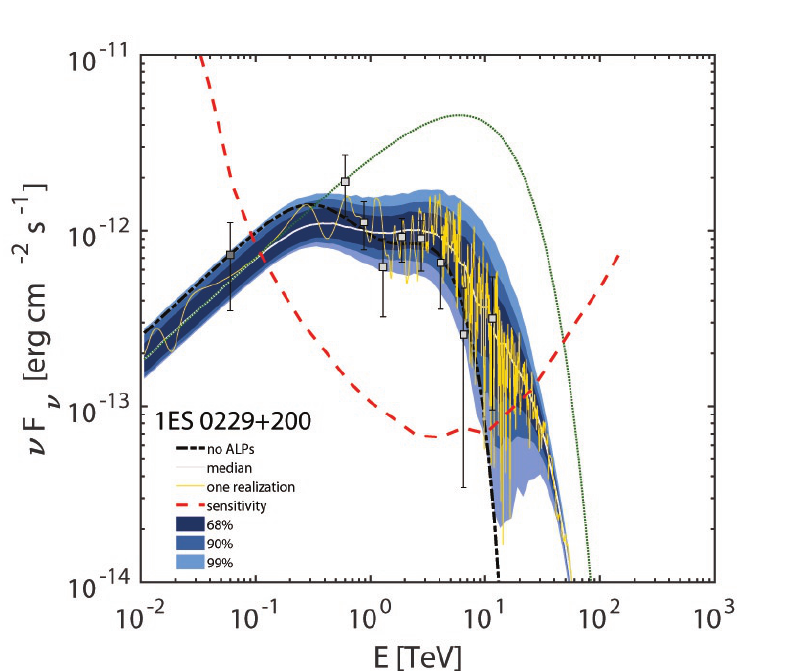
Figure 26. Same as Figure 25 but for 1ES 0229+200. The dark gray squares are the spectrum detected by Fermi/LAT [260] while the light gray squares are the spectrum observed by HESS [261]. (Credit [116]).